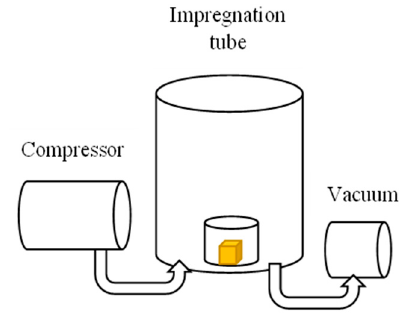
Figure 2. Impregnation process.